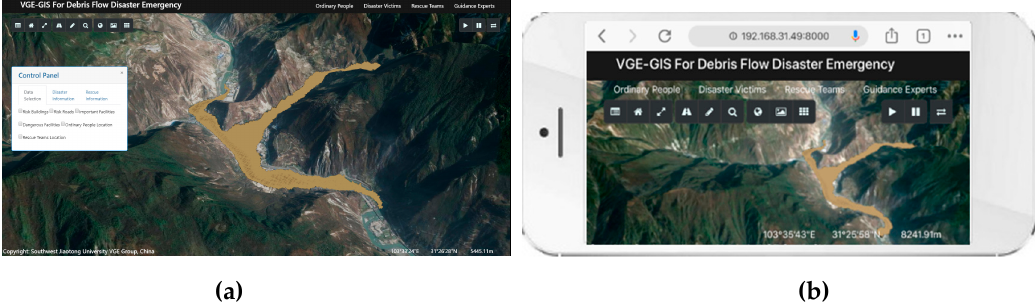
Figure 6. Prototype system for debris flow disaster visualization: ( a ) Prototype system run on a desktop terminal and ( b ) prototype system run on a mobile terminal.